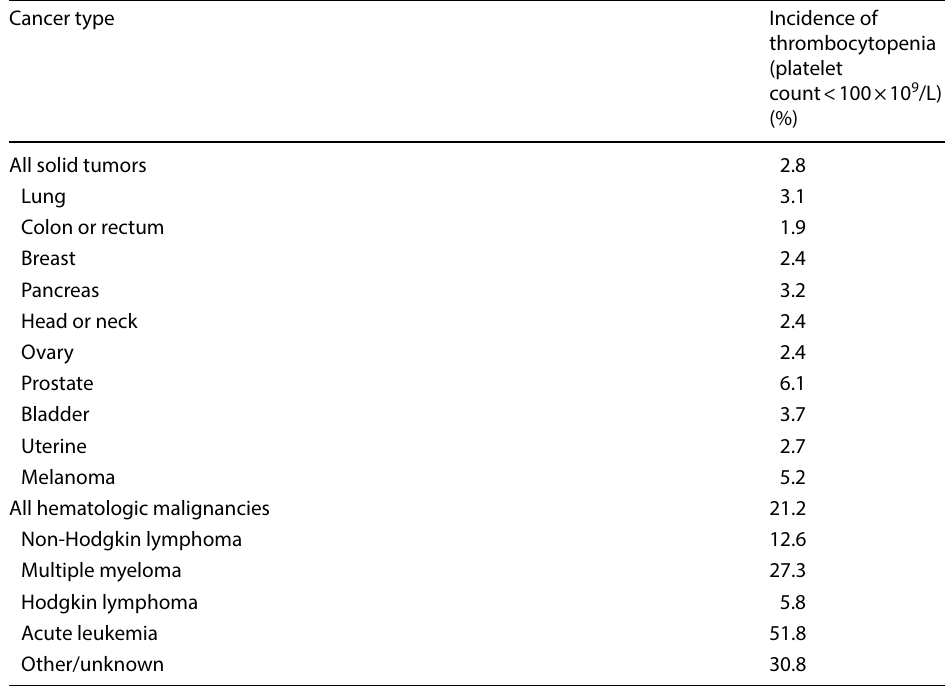
Table 1 The incidence of thrombocytopenia in typical cancer types before chemotherapy